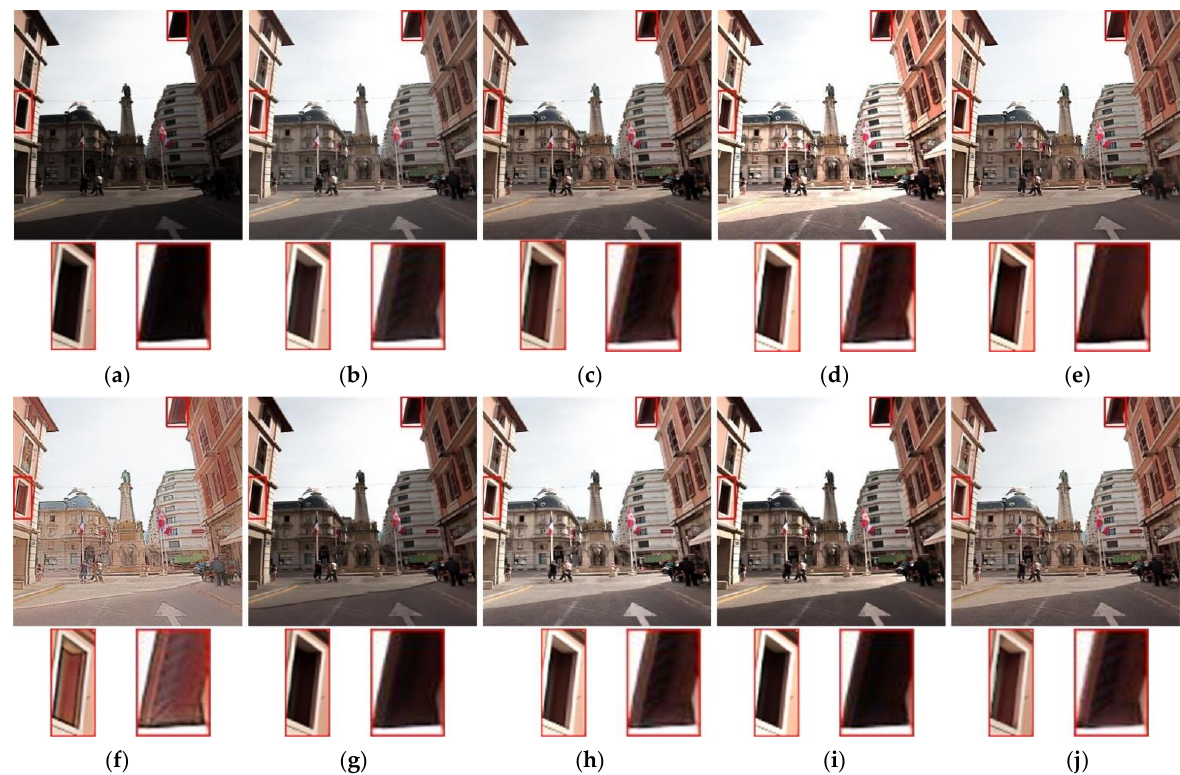
Figure 12. Enhanced results of “Window and Eave” image. ( a ) Original image; ( b ) BIMEF; ( c ) MEF; ( d )